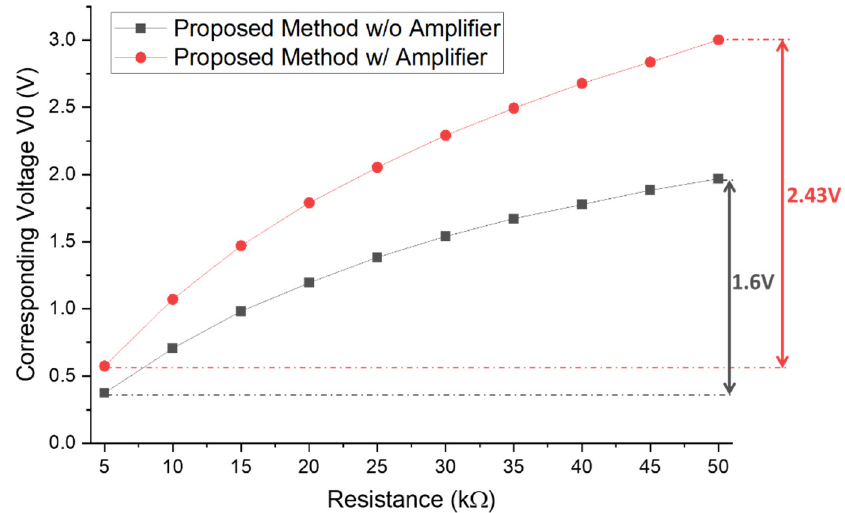
Figure 14. The corresponding voltage range (V0) that is read by the ADC for the proposed method with and without an amplifier.